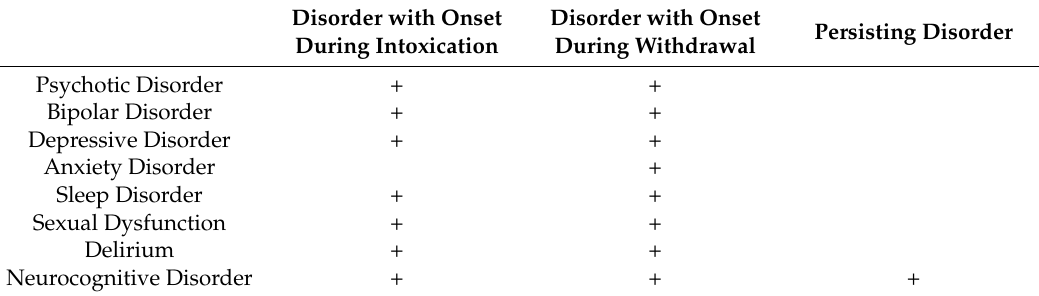
Table 3. Benzodiazepine-induced disorders in the Diagnostic and Statistical Manual of Mental Disorders, 5th Edition